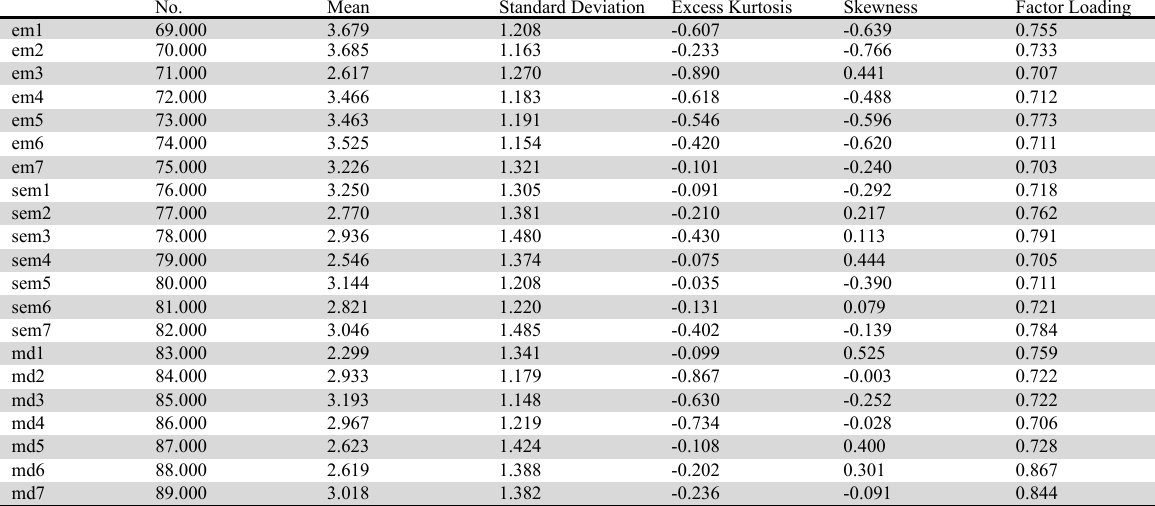
Means, standard deviation, kurtosis, skewness, and VIF (Continued)